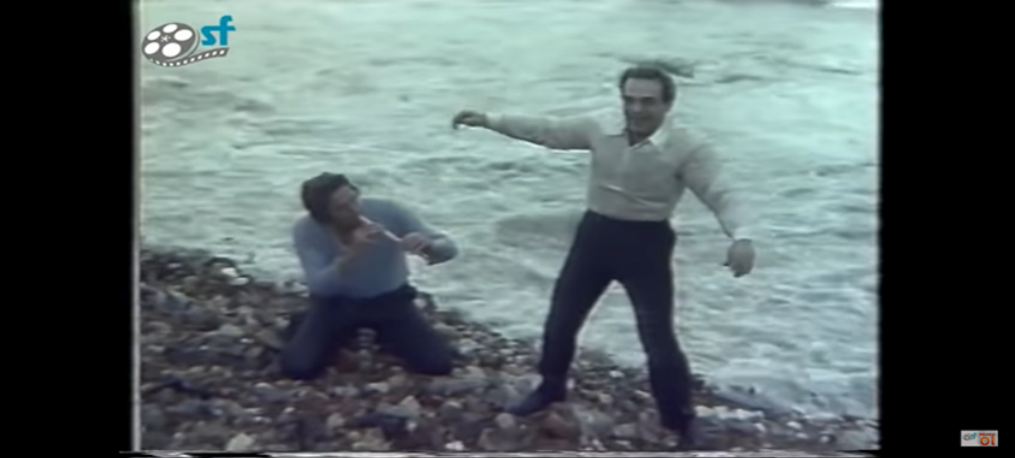
Figure 2- Yavuz and Alpgiray dancing on the Turkish coast with the Nationalist song “Çırpınırdı Karadeniz